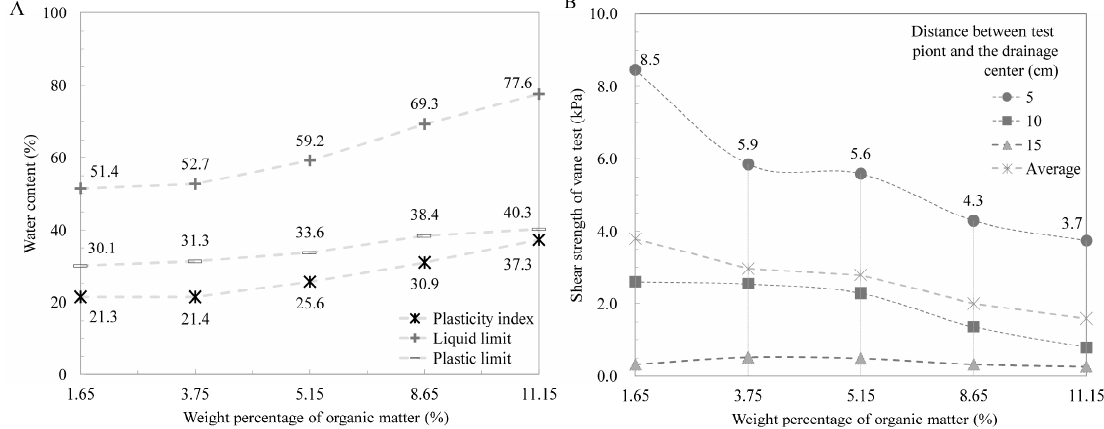
Figure 1. Physical and mechanical properties of hydraulic mud. ( A ) Physical properties of hydraulic mud. ( B ) Mechanical properties of hydraulic mud.